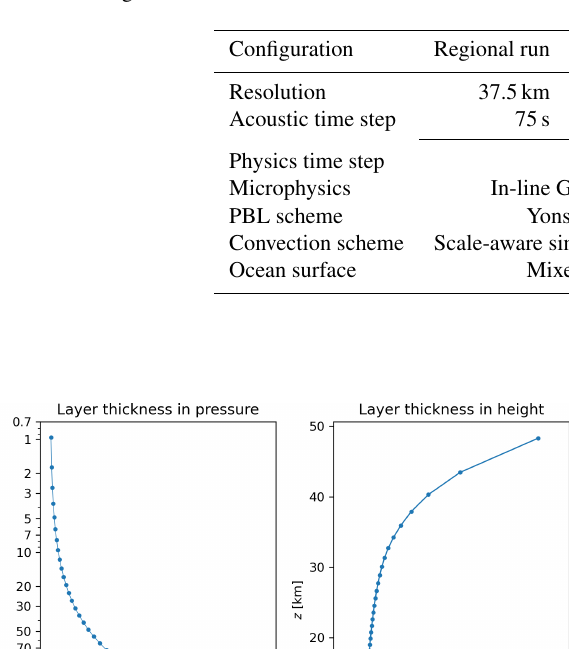
Figure 1. Two grid configurations. (a) A 37.5km regional grid (red mesh). (b) A 100km global grid (black mesh) with a nest grid (red mesh) that is refined by a factor of 3; the position and the grid size of the nest grid are the same as those of the regional grid. Each grid box represents 12 × 12 actual grid boxes. Heavy black lines are the cubed-sphere edges and heavy red lines are the boundaries of the regional/nest domain. Table 1. Model configurations of the regional and the global–nest run. For the global–nest run, resolution and acoustic time step are shown in the format of global/nest.